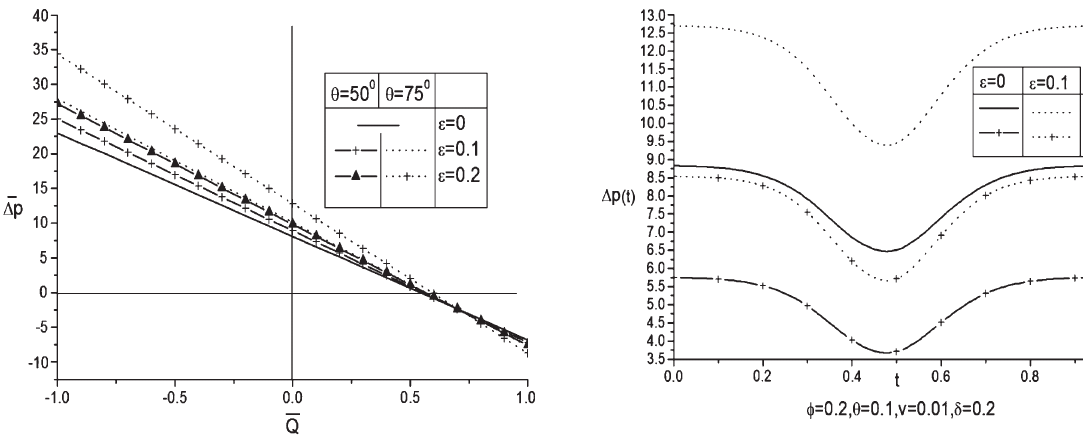
Fig. 6. Variation of pressure rise over the time interval t with dif- ferent values of eccentric parameter (cid:2) with different main flow rate values.